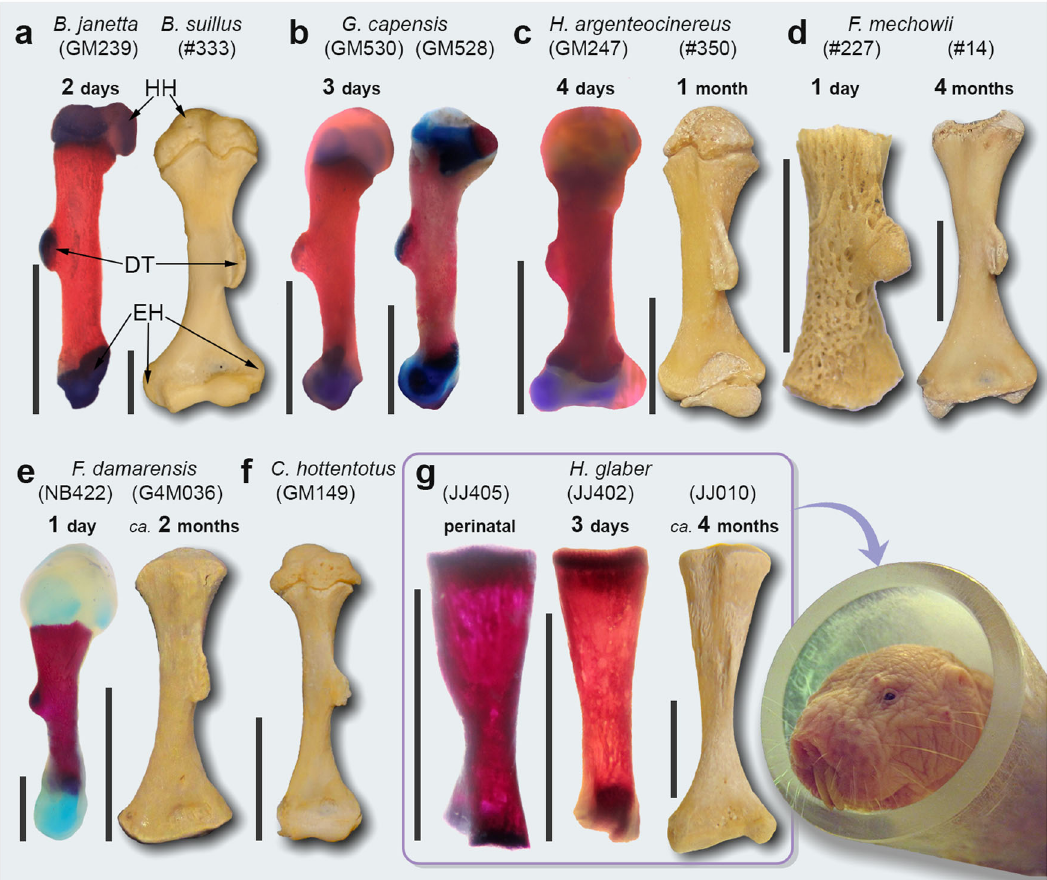
Fig. 2 Early postnatal development of the humerus of African mole-rats. a Well-developed deltoid tuberosity (DT) in Bathyergus suillus and B. janetta originated from a localized primordium in the diaphysis. Chondroepiphyses show an enlarged humeral head (HH) and wide cartilaginous epicondyles (EH). Similar development of humerus in b Georychus capensis , c Heliophobius argenteocinereus , d Fukomys mechowii , e F. damarensis , and f Cryptomys hottentotus . g Note the absence of cartilaginous tissue in the diaphysis of Heterocephalus glaber . Scale bars represent 5.0 mm, except in specimens JJ402, JJ405, JJ010, and #227, which represent 2.5 mm. Stained specimens are in lateral view, except GM247 which is in posterolateral view. Non-stained specimens are shown in anterior